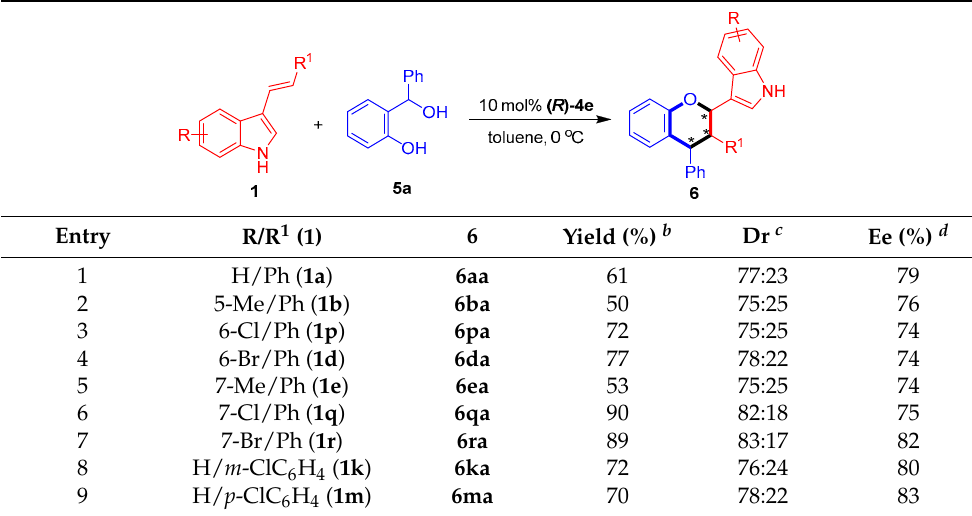
Table 6. Substrate scope of 3-vinylindoles 1 for [2 + 4] cycloaddition with o -hydroxybenzyl alcohol 5a a .